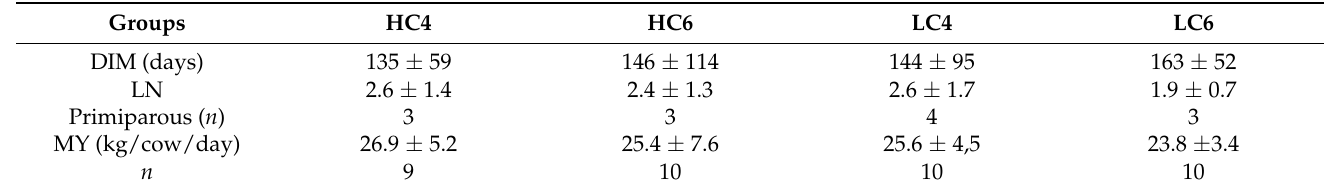
Table 1. Characteristics of the group at the beginning of the trial. Values are means ± standard deviation.